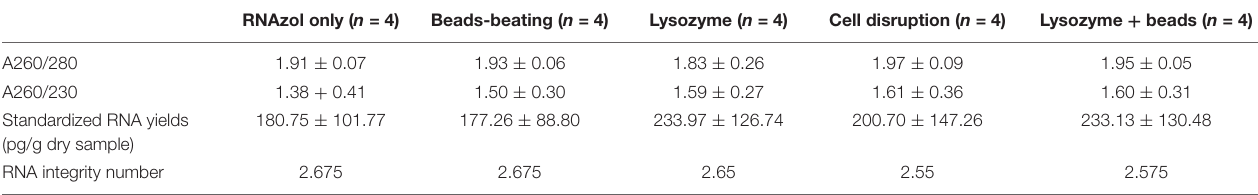
TABLE 1C | RNA purity (A260/280; A260/230), standardized yields and RIN (RNA integrity number) for organic isolation-based groups after additional purification step. RNAzol only ( n =